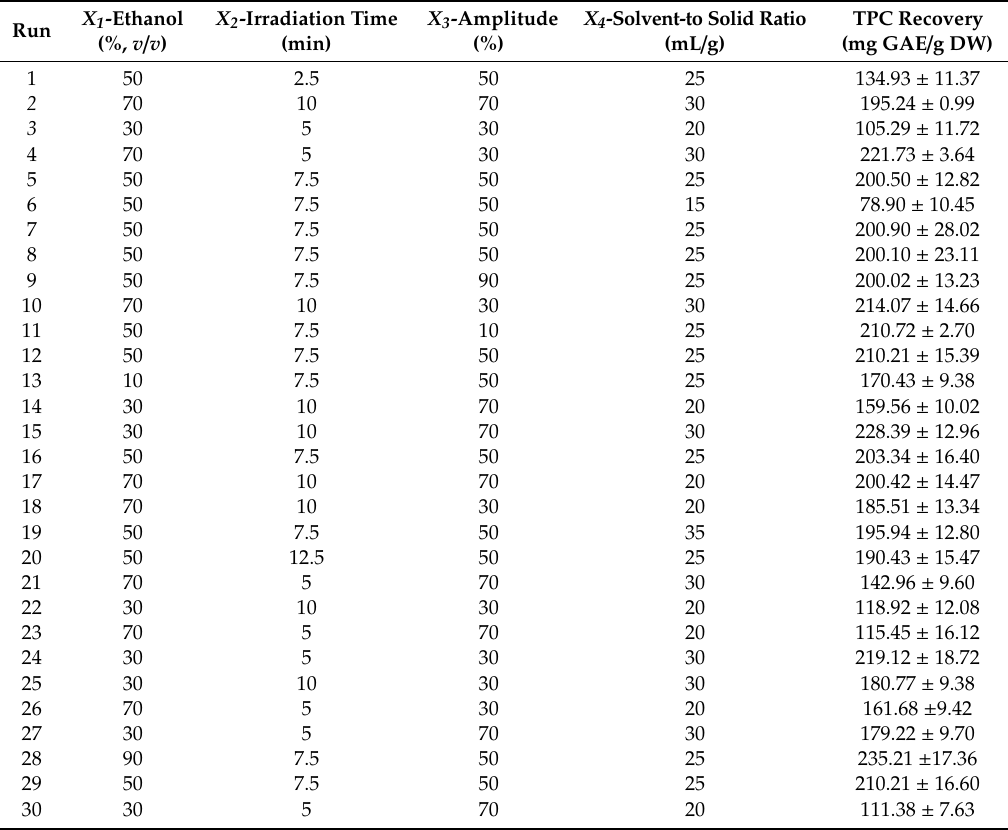
Table 1. Central composite design with the observed responses and predicted values for yield of total phenolic compounds of Myrtus communis pericarp using the UAE